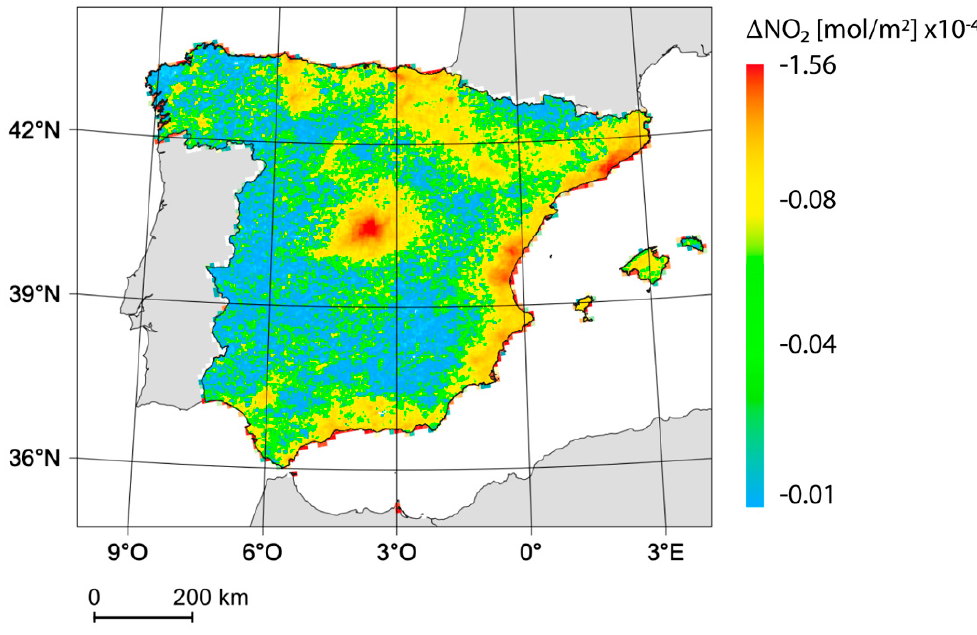
Figure 7. Mean variation of NO 2 VCD between one month before and after 15 March 2020 in Spain.